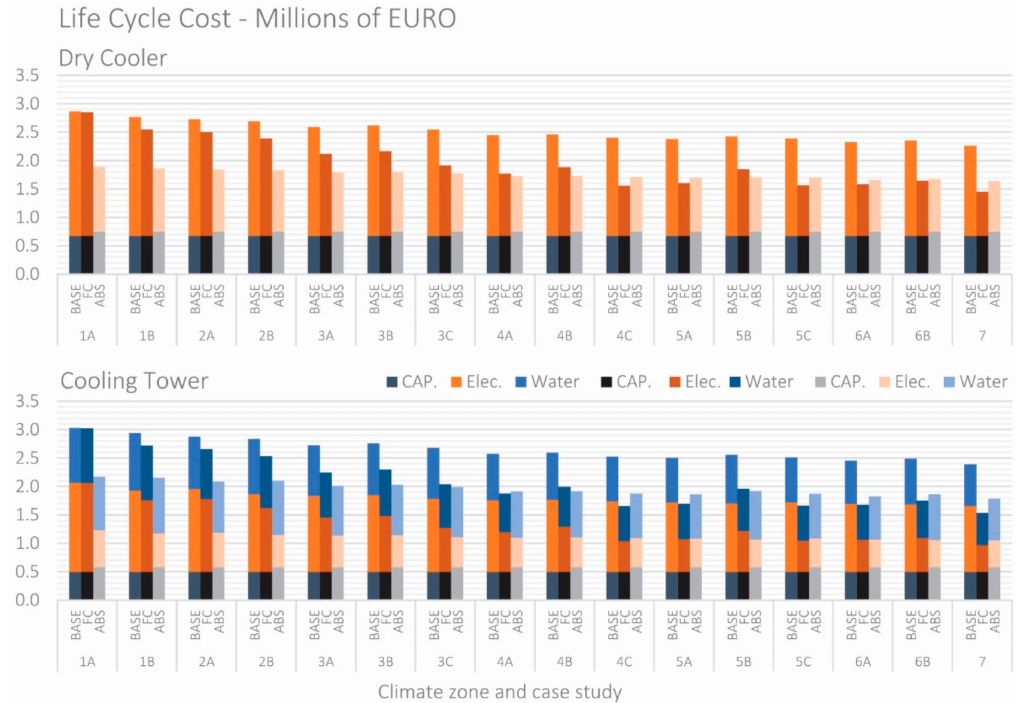
Figure 10. Life cycle cost (LCC) analysis based on climate zone and case study at mean electricity and water prices. CAP. is for plant capital costs, Elec. and Water are the life cycle operational expenses for electricity and water,